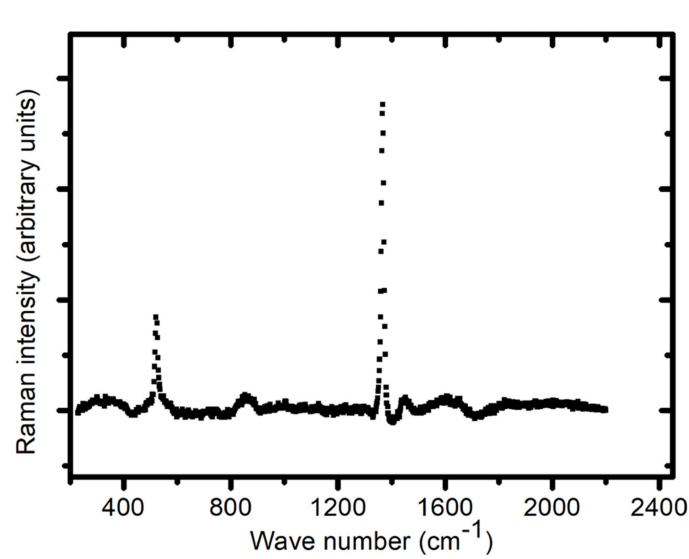
Figure 5. Raman spectra of silicide particles in La − Si − O − N glass.